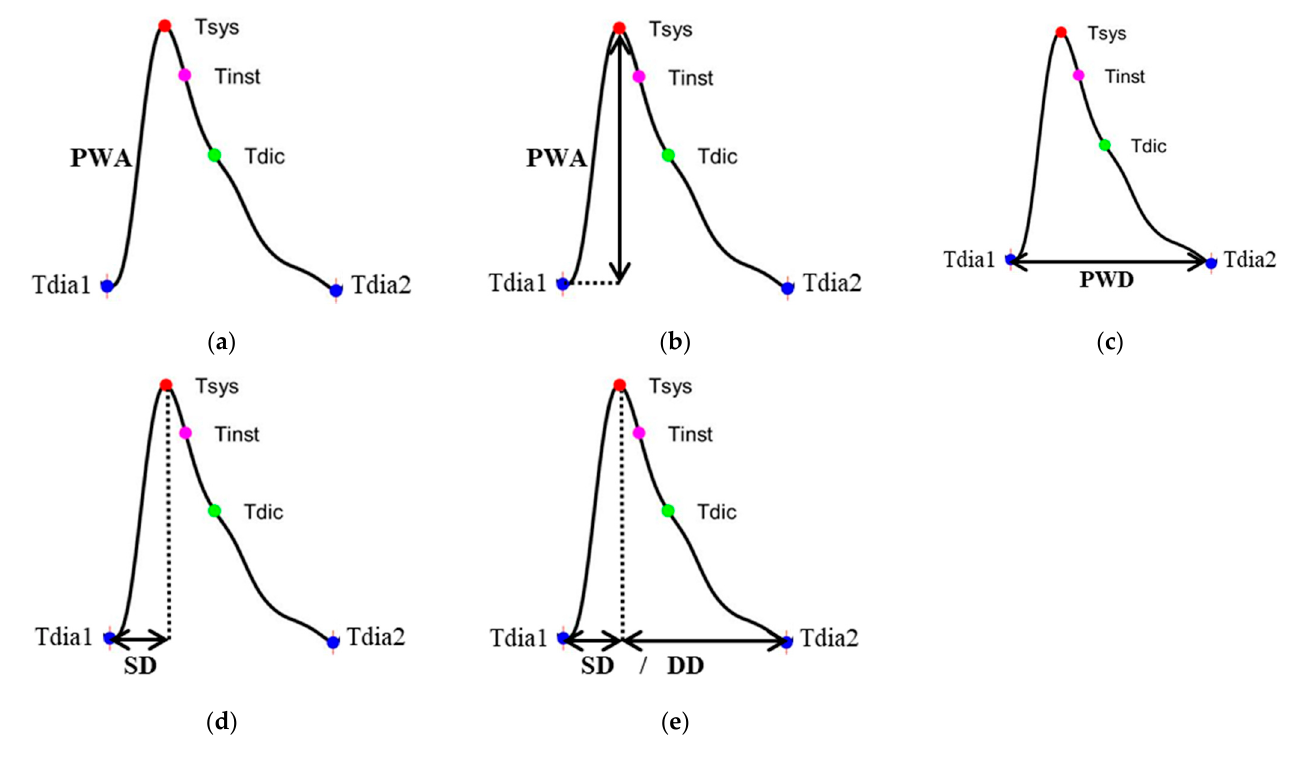
Figure 4. ( a ) The four characteristics of pulse, ( b ) the pulse wave amplitude (PWA), ( c ) the pulse wave duration (PWD), ( d ) the systolic duration (SD) of pulse wave, and ( e ) the ratio of SD and diastolic duration (DD).